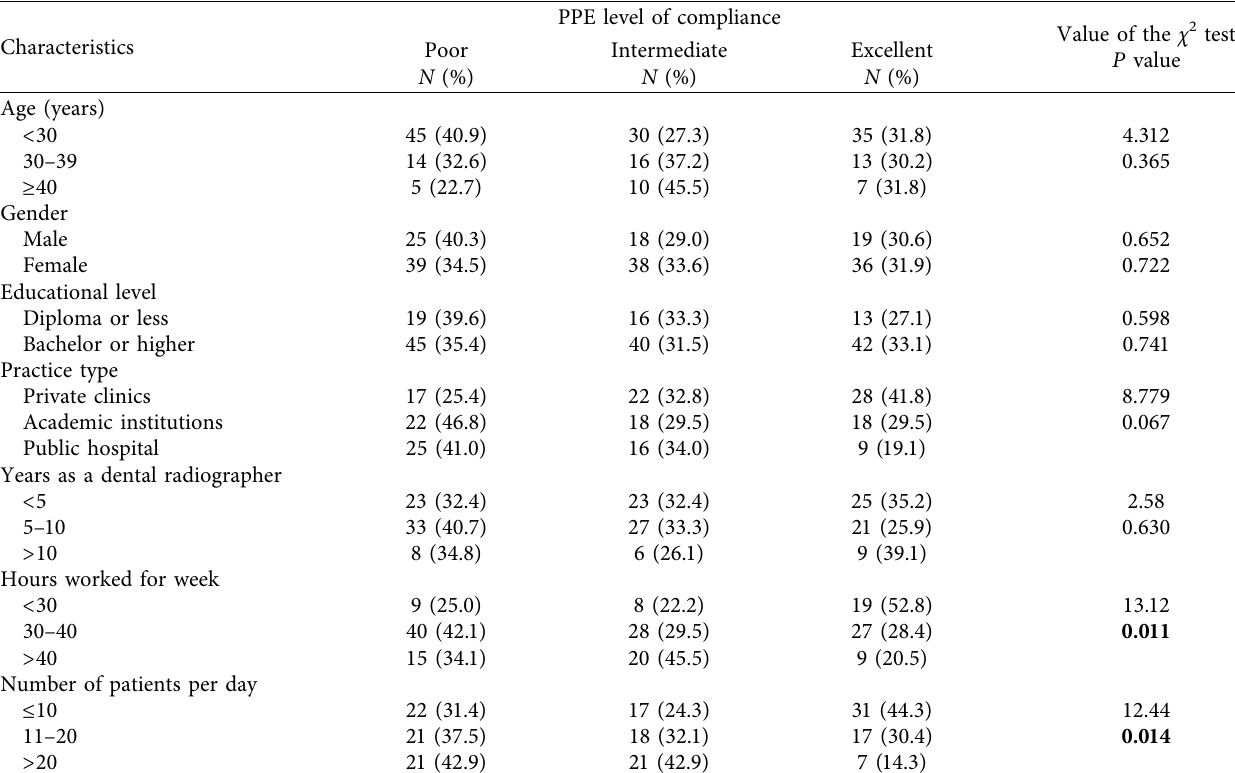
Table 5: The level of compliance with PPE practices ( N �